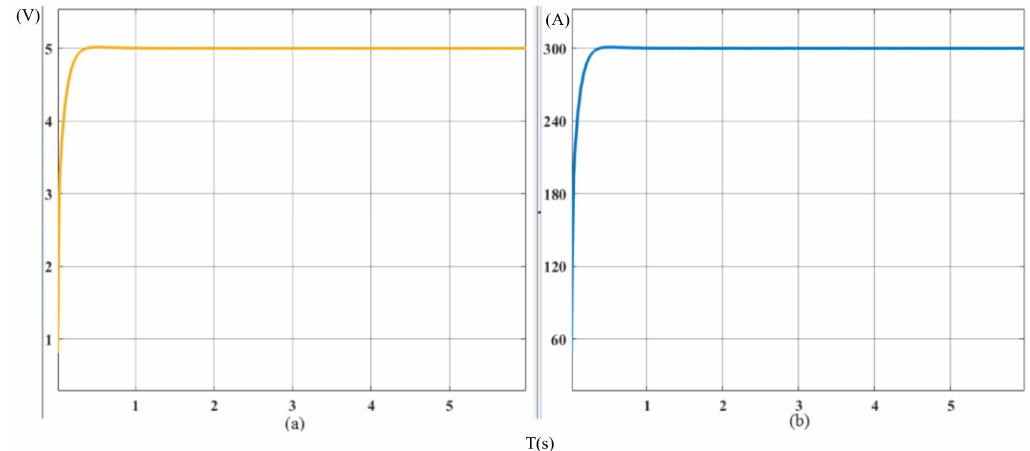
Figure 12. DC output waveforms controlled by the nonlinear feed-forward PID control method: ( a ) voltage waveform; ( b ) current